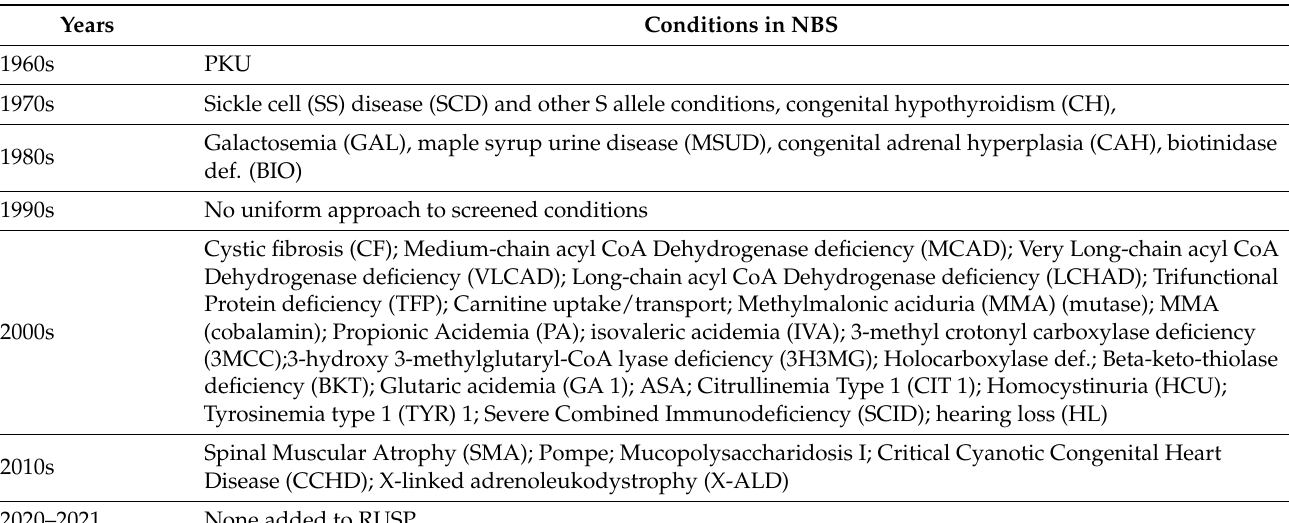
Table 2. Timing of NBS